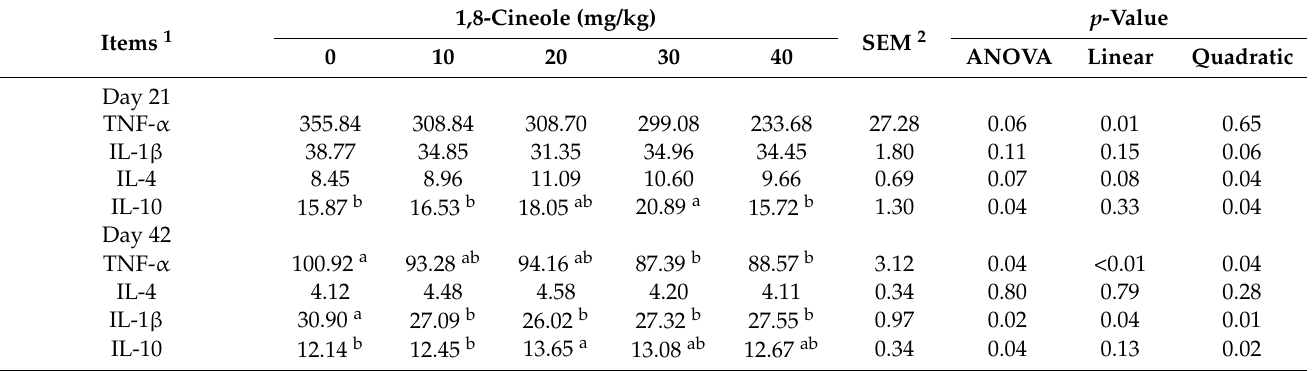
Table 6. Effects of dietary 1,8-cineole inclusion on serum cytokines level of broiler chickens